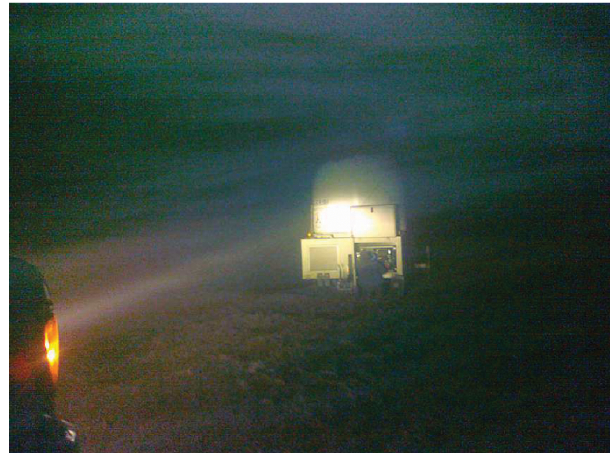
Figure 3. The X-band mobile radar during very di ffi cult operating conditions. Intense ash-fall caused very low visibility and darkness. Photo Geirfinnur S. Sigurðsson, 22 May 2011 at